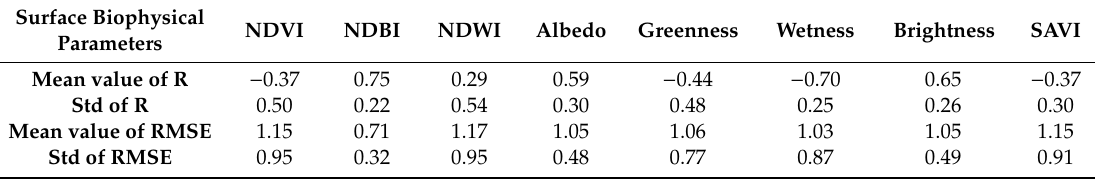
Table 3. Mean and standard deviation of the correlation coe ffi cient and RMSE between the observed and modeled values of the LST variations at the pixel scale based on the variations of each surface biophysical